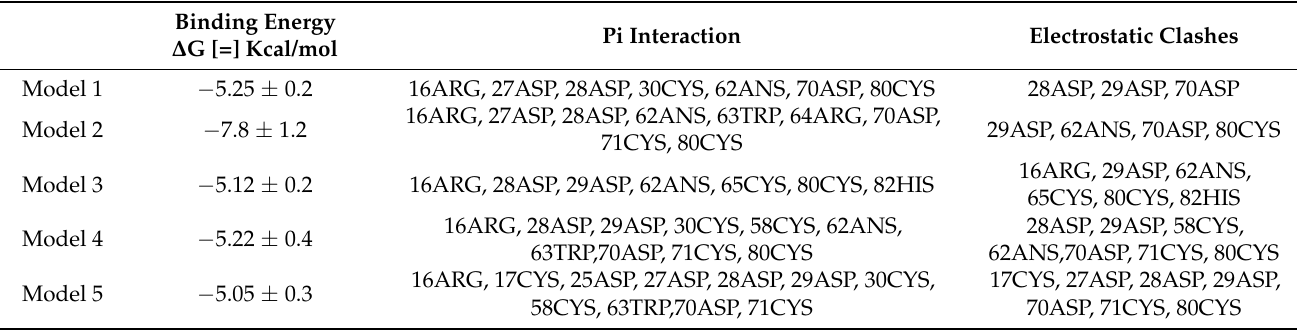
Table 1. Binding of angiopep-2 to CR56 of LRP-1: characteristic binding energy and classification of receptor residues involved in the